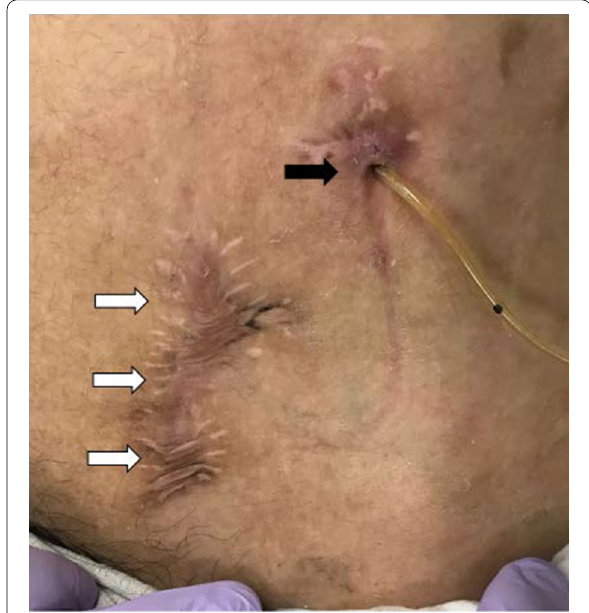
Fig. 3 Appearance one and a half years after the operation. The exit for intestinal tube (black arrow) and the wound after closure of the ACE procedure that used a balloon-button gastrostomy tube (white